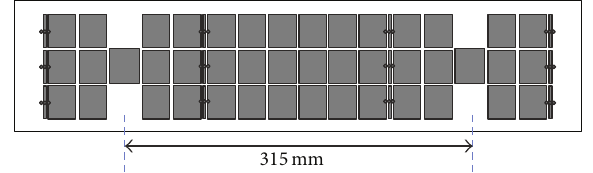
Figure 8: Antennas coupled using an